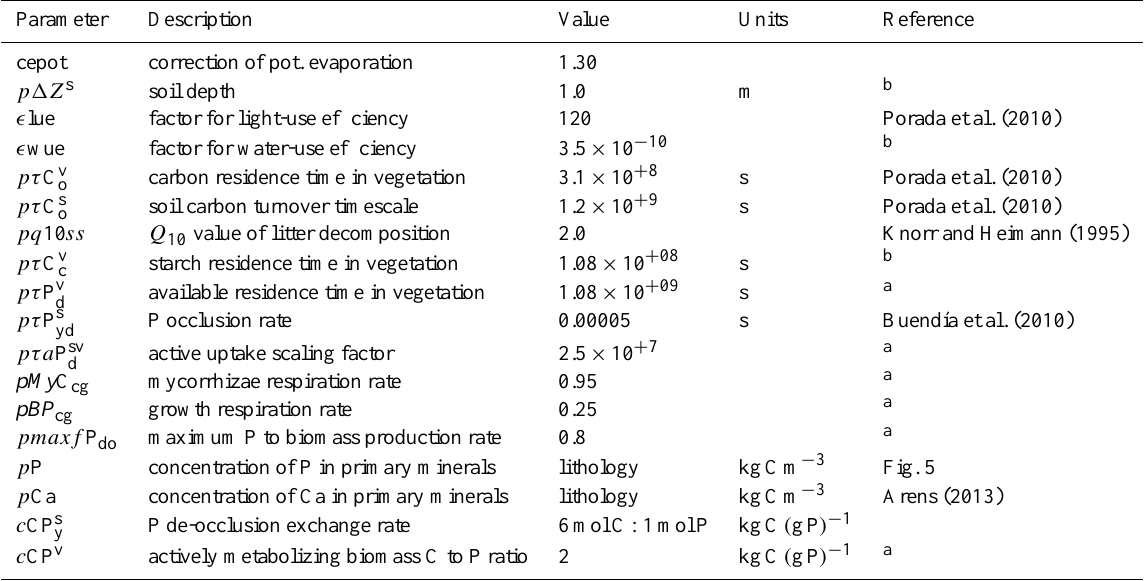
Table A4. Description of model parameters. Parameters with the reference a are set by personal assessment (see text) while parameters marked by b are calibrated to values, which lead to reasonable model output, considering the data used to evaluate the model.